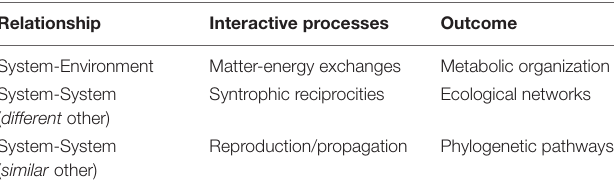
TABLE 1 | Minimal interactive dimensions required for the construction of biological